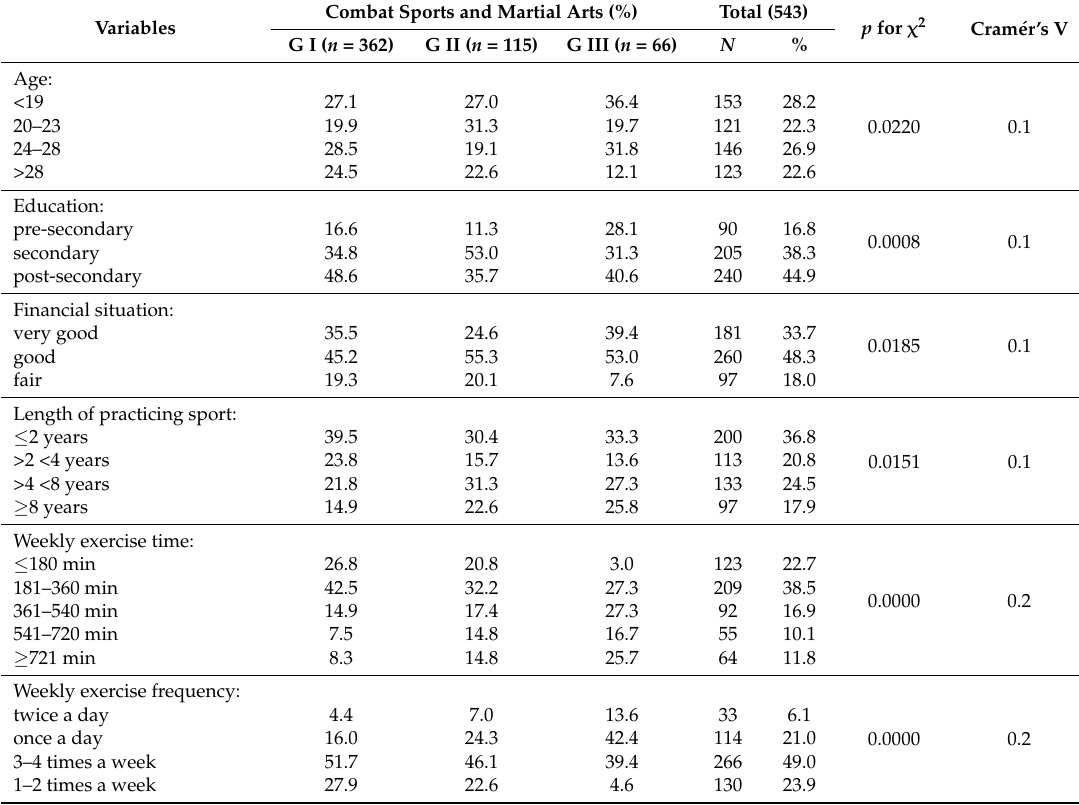
Table 1. Characteristics of people who practice combat sports and martial arts (independence χ 2 test, Cram é r’s V).